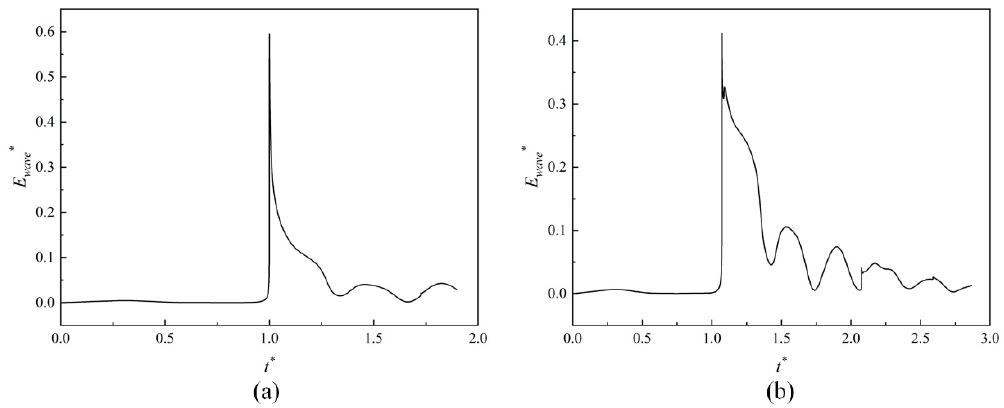
Figure 13. Time-evolution of the bubble acoustic energy. ( a ) Bubble collapse in the far-field region; ( b ) bubble collapse near the wall.